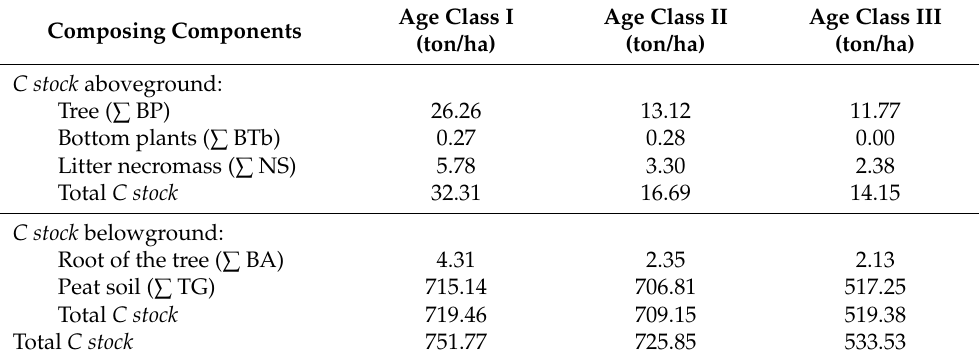
Table 11. The total average amounts of stored carbon ( C stock ) in the study location in D. polyphylla stands with three age classes.